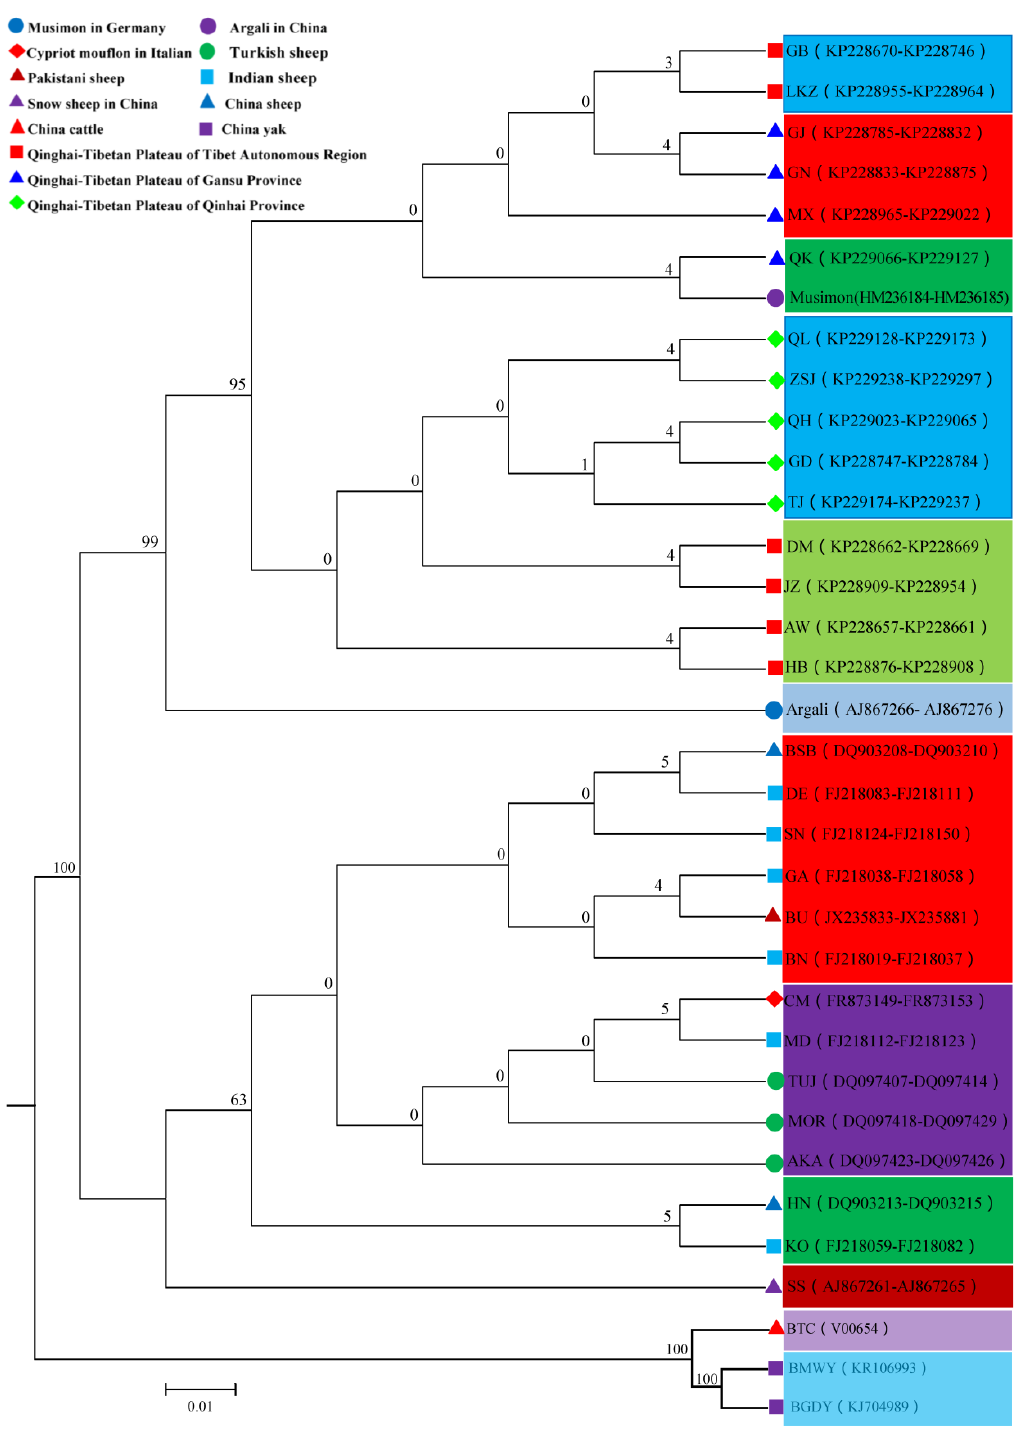
Figure 4. Neighbor joining Phylogenetic Tree of 34 Populations on the basis of 878 Sequences of MT-CYB . The distances were calculated by using the Maximum Composite Likelihood method and units are the number of base substitutions per site.